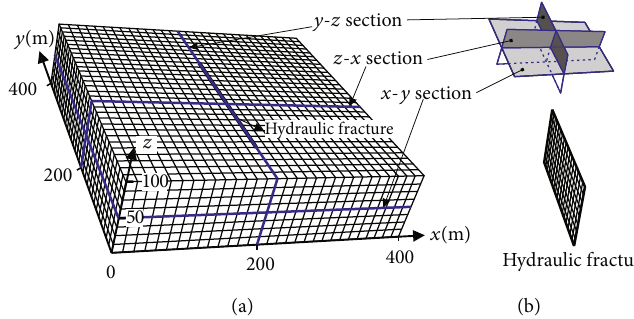
Figure 3: A schematic diagram of the 3D physical model.